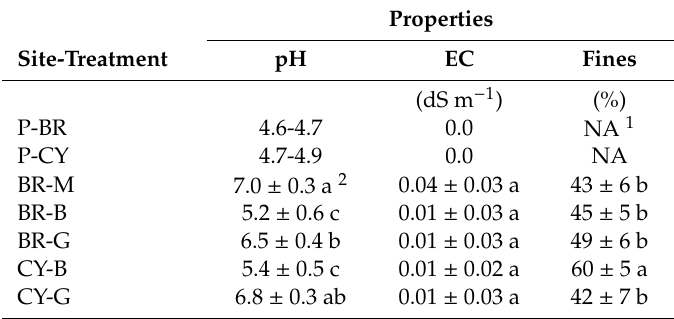
Table 3. Soil properties (pH, electrical conductivity (EC), percent fines) for pre-mine soils at each site (P-BR and P-CY), Birch River (BR-M, BR-B and BR-G) and Catenary (CY-B and CY-G) mine soils (means ± one standard error).